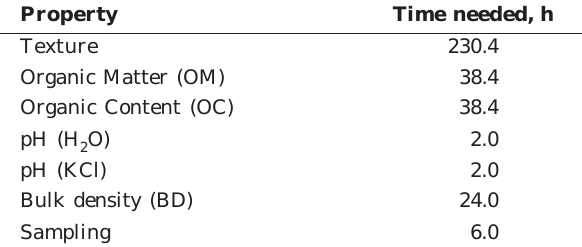
Table 4. Times required for the determination of soil properties